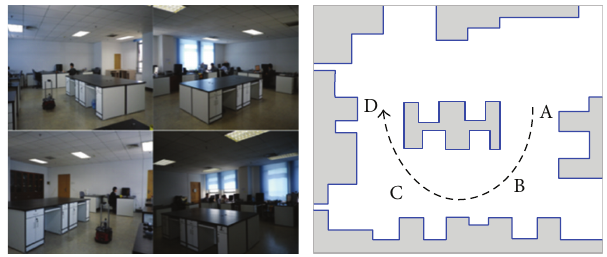
Figure 6: The experimental